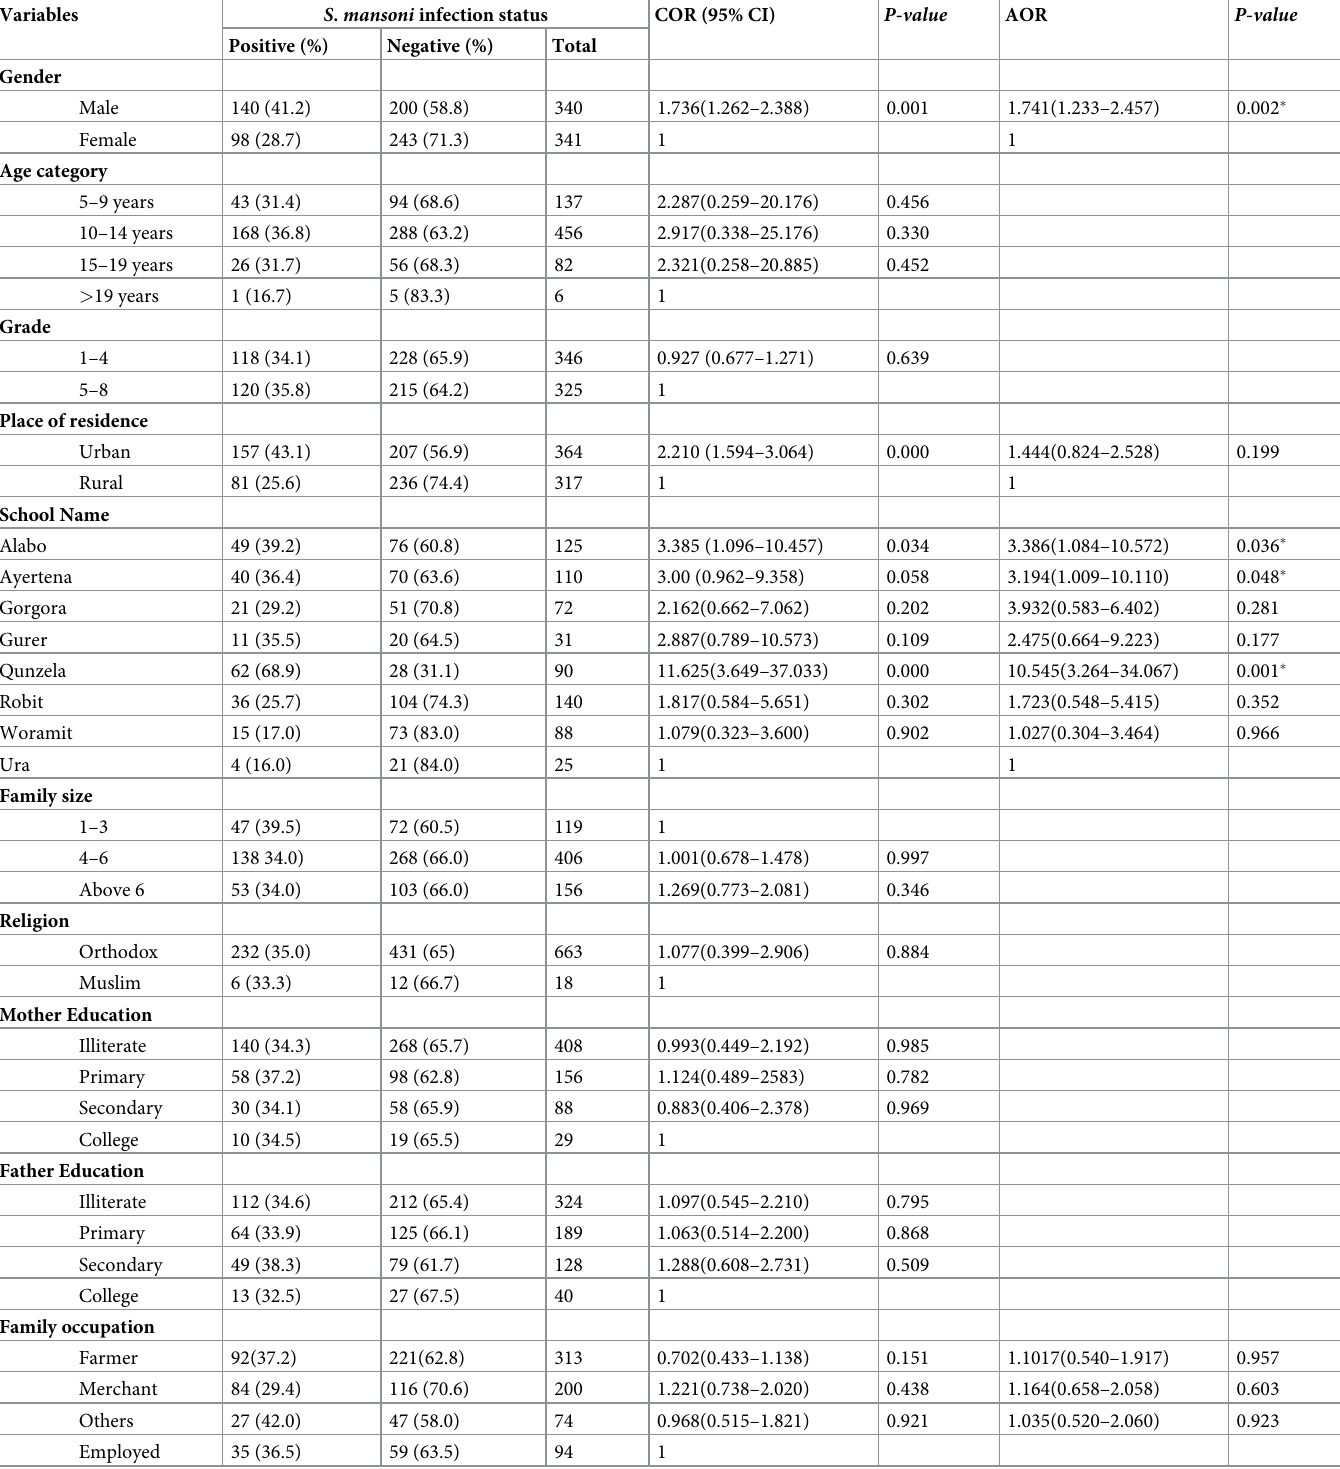
Table 4. Univariate and multivariate analyses of risk factors associated with S . mansoni infection among schoolchildren attending primary schools around Lake Tana, northwest, Ethiopia,